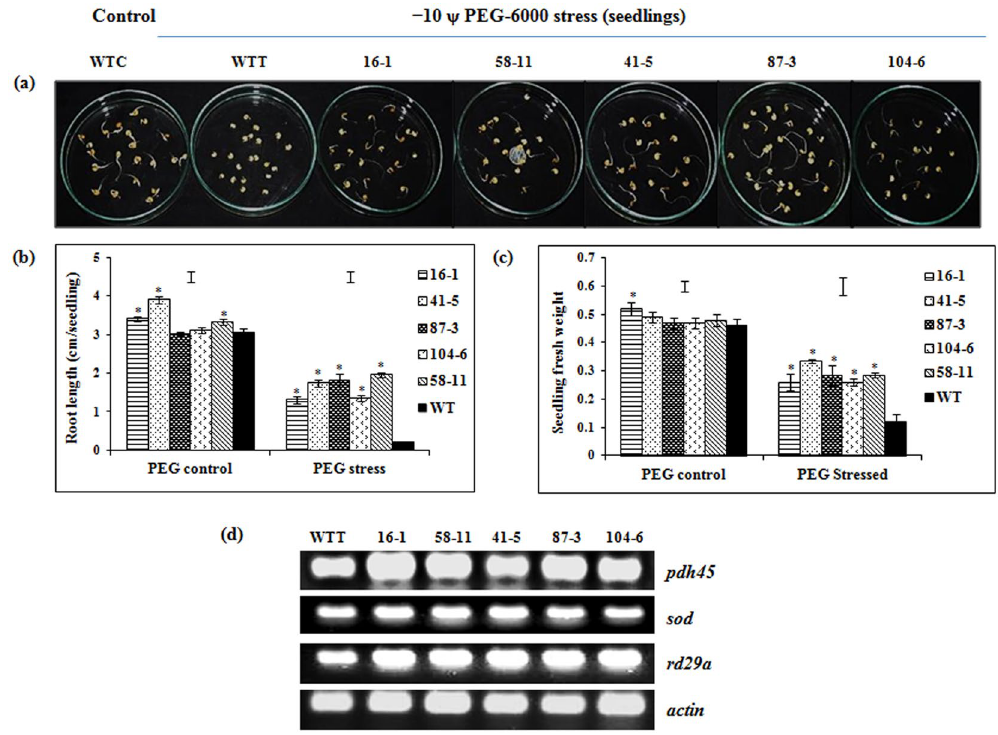
Figure 3. Response of the selected transgenic events to simulated moisture stress. ( a ) Effect of moisture stress ( − 10 ψ PEG-6000) on the seedlings of transgenic events and wild type; ( b ) seedling root length (cm); ( c ) seedling fresh weight (g); ( d ) sqRT-PCR analysis of PDH45 and stress-responsive genes in the stressed seedlings. (WTC = wild type control; WTT = wild type treated. Bars in the graph indicate LSD value at P < 0.05; ( * ) indicates significant differences at P <